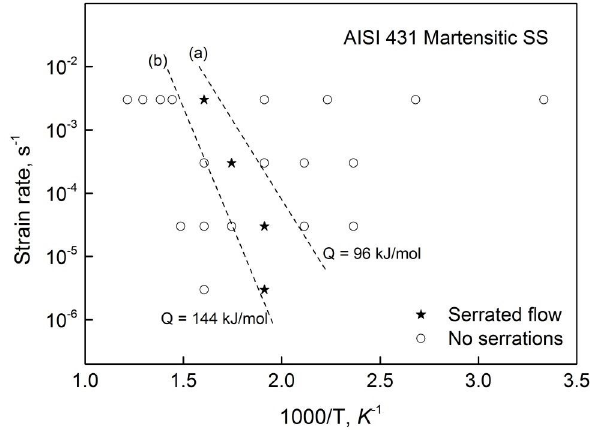
Figure 10: Arrhenius plot of Log[strain rate] vs (1000/Temperature) for the appearance of serrations/jerky flow in the tensile curve of AISI 431 martensitic stainless